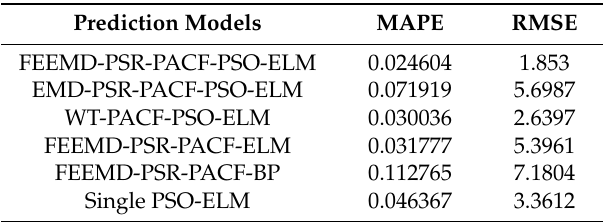
( b ) Figure 12. The results of the analysis of the carbon price prediction for Beijing. ( a ) is the root mean square error (RMSE) value; ( b ) is the mean absolute percentage error (MAPE) value.